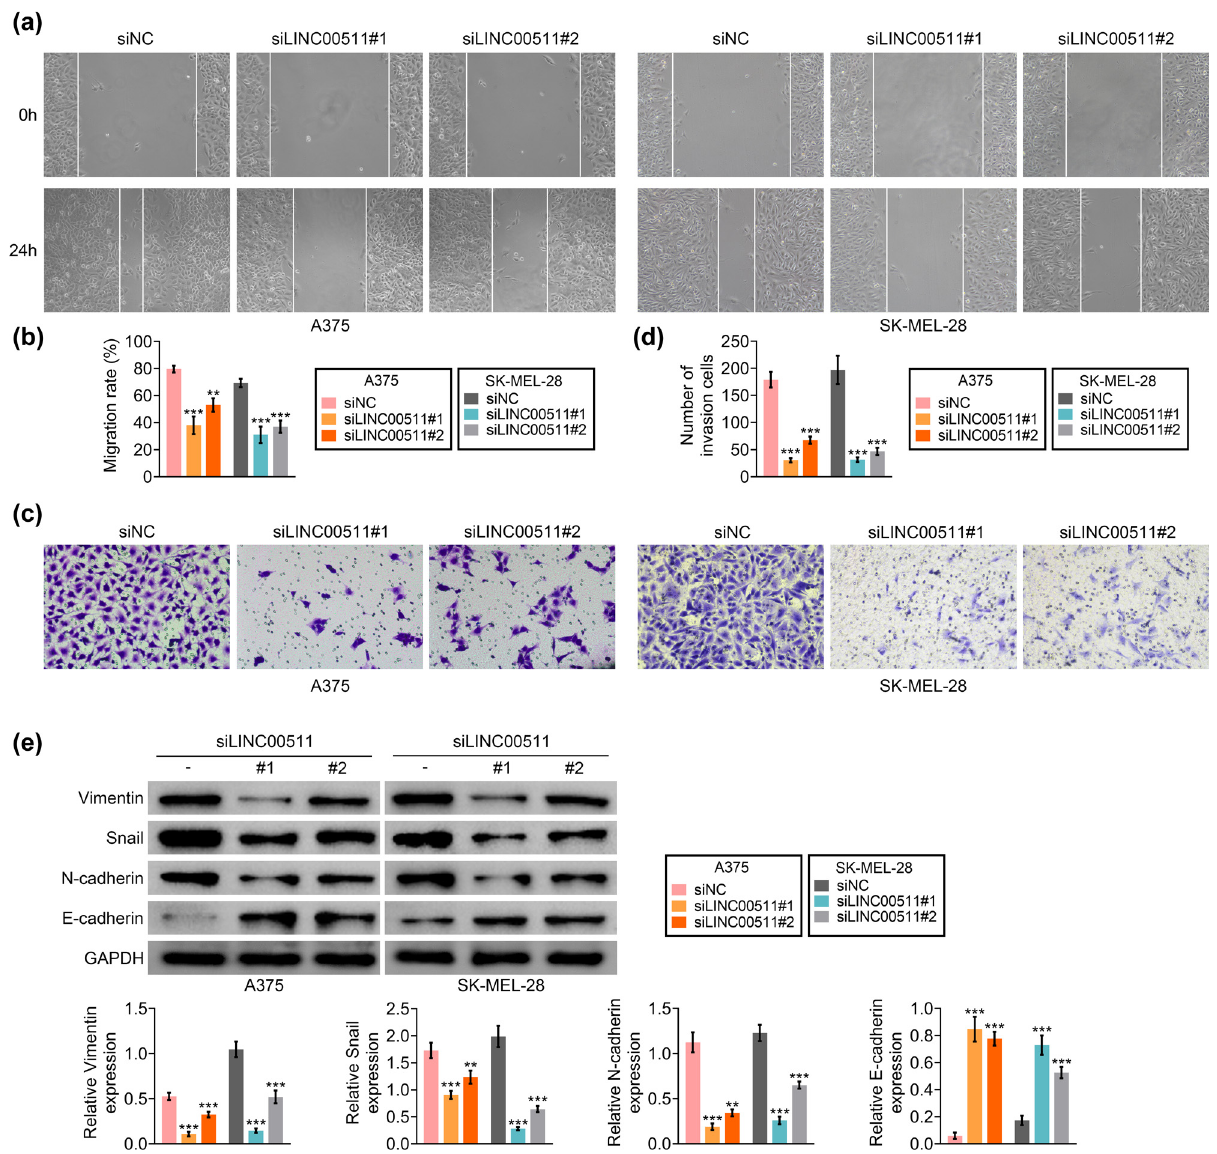
Figure 2: LINC00511 - promoted cell metastasis of melanoma. ( a ) Transfection with si LINC00511#1 or si LINC00511#2 decreased cell migration of A375 and SK - MEL - 28. ( b ) Relative migration cells in A375 and SK - MEL - 28 that were transfected with si LINC00511#1 or si LINC00511#2. ( c ) Transfection with si LINC00511#1 or si LINC00511#2 decreased cell invasion of A375 and SK - MEL - 28. ( d ) Relative invasion cells in A375 and SK - MEL - 28 that were transfected with si LINC00511#1 or si LINC00511#2. ( e ) Transfection with si LINC00511#1 or si LINC00511#2 upregulated protein expression of E - cadherin, downregulated vimentin, snail, and N - cadherin in A375 and SK - MEL - 28. **, *** vs siNC, p < 0.01, p <